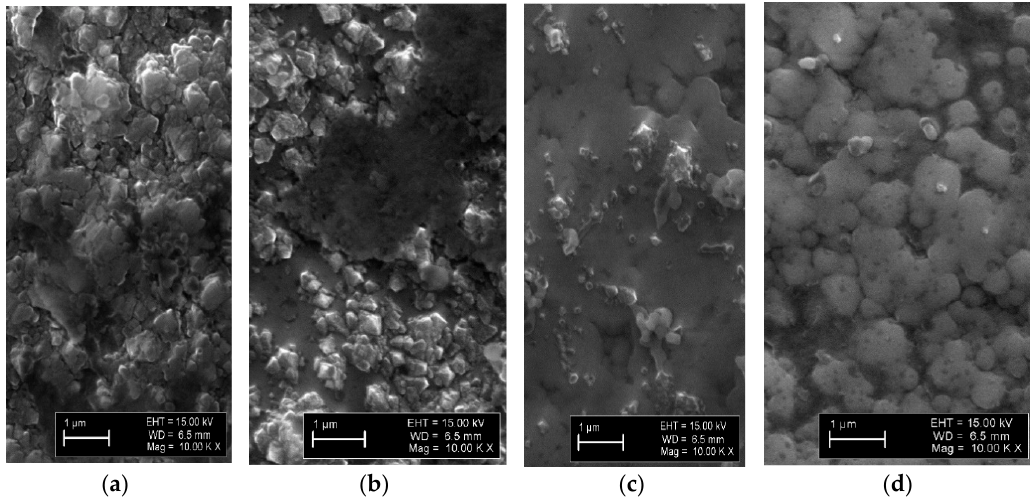
Figure 5. SEM images taken on the wear scar after the test at RT on the Al 2 O 3 /NCD film. The images were taken from ( a ) the center of the wear scar ( b , c ) were taken in the middle of the wear scar to ( d ) the border of the wear scar images.